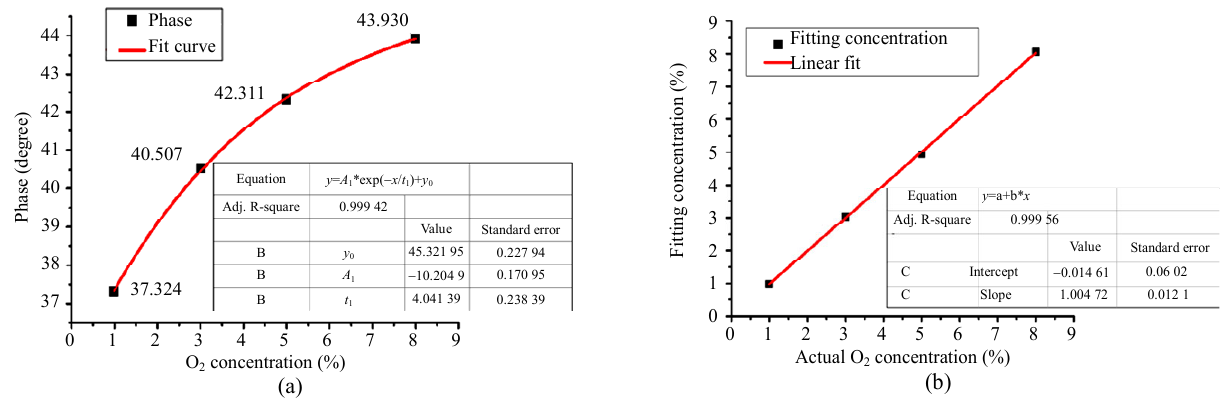
Fig. 6 Measurements linearity of different concentrations: (a) the phase measurements for different concentrations and (b) the fitting concentrations measured by the fit